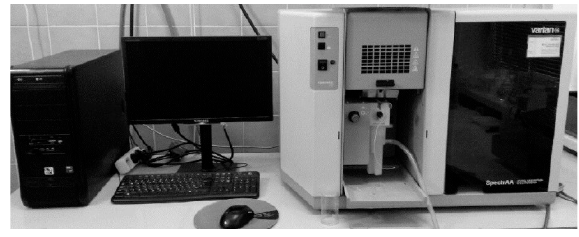
Figure 1. Atomic absorption spectroscopy Varian AA280Z.